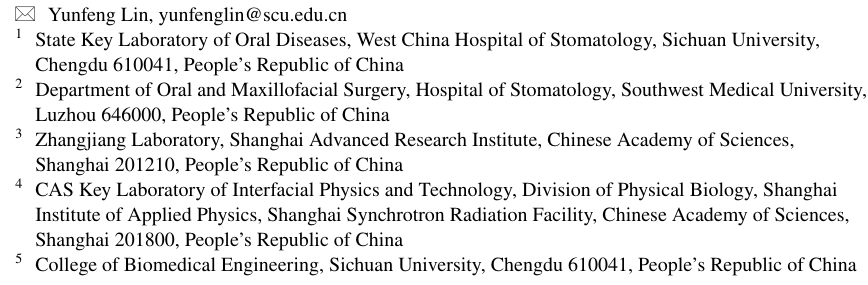
Fig. 4, Fig. S16 and Fig. S17 were wrong. They should be as follows. We are so sorry to make the mistake. We have carefully checked the images and found that the CD86 staining of muscle in HFD + tFNAs group was wrong when merging the single channels. CD86 is a marker for macrophages, and here we want to observe the change of iNOS. And the image of iNOS staining was correct. We are so sorry that we did not carefully checked and double-checked these